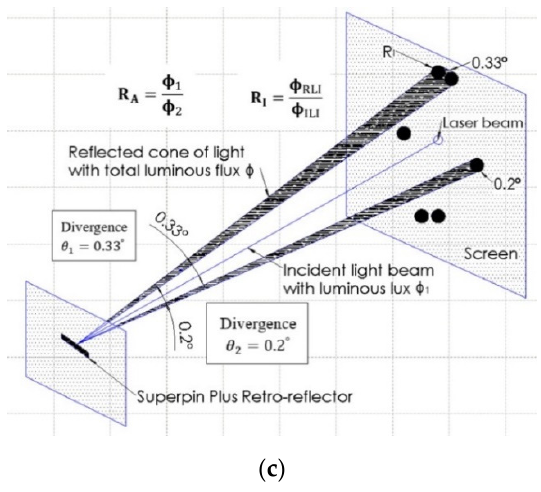
Figure 1. The formula of retro-reflected light by ( a ) the EU Economic Commission for Europe (ECE) regular in ([16], Figure 1), ( b ) the ECE SuperPin in ([24], Figure 1), and ( c ) the ECE and US Society of Automotive Engineers (SAE) SuperPin Plus reflex reflector, an extension of SuperPin [24].